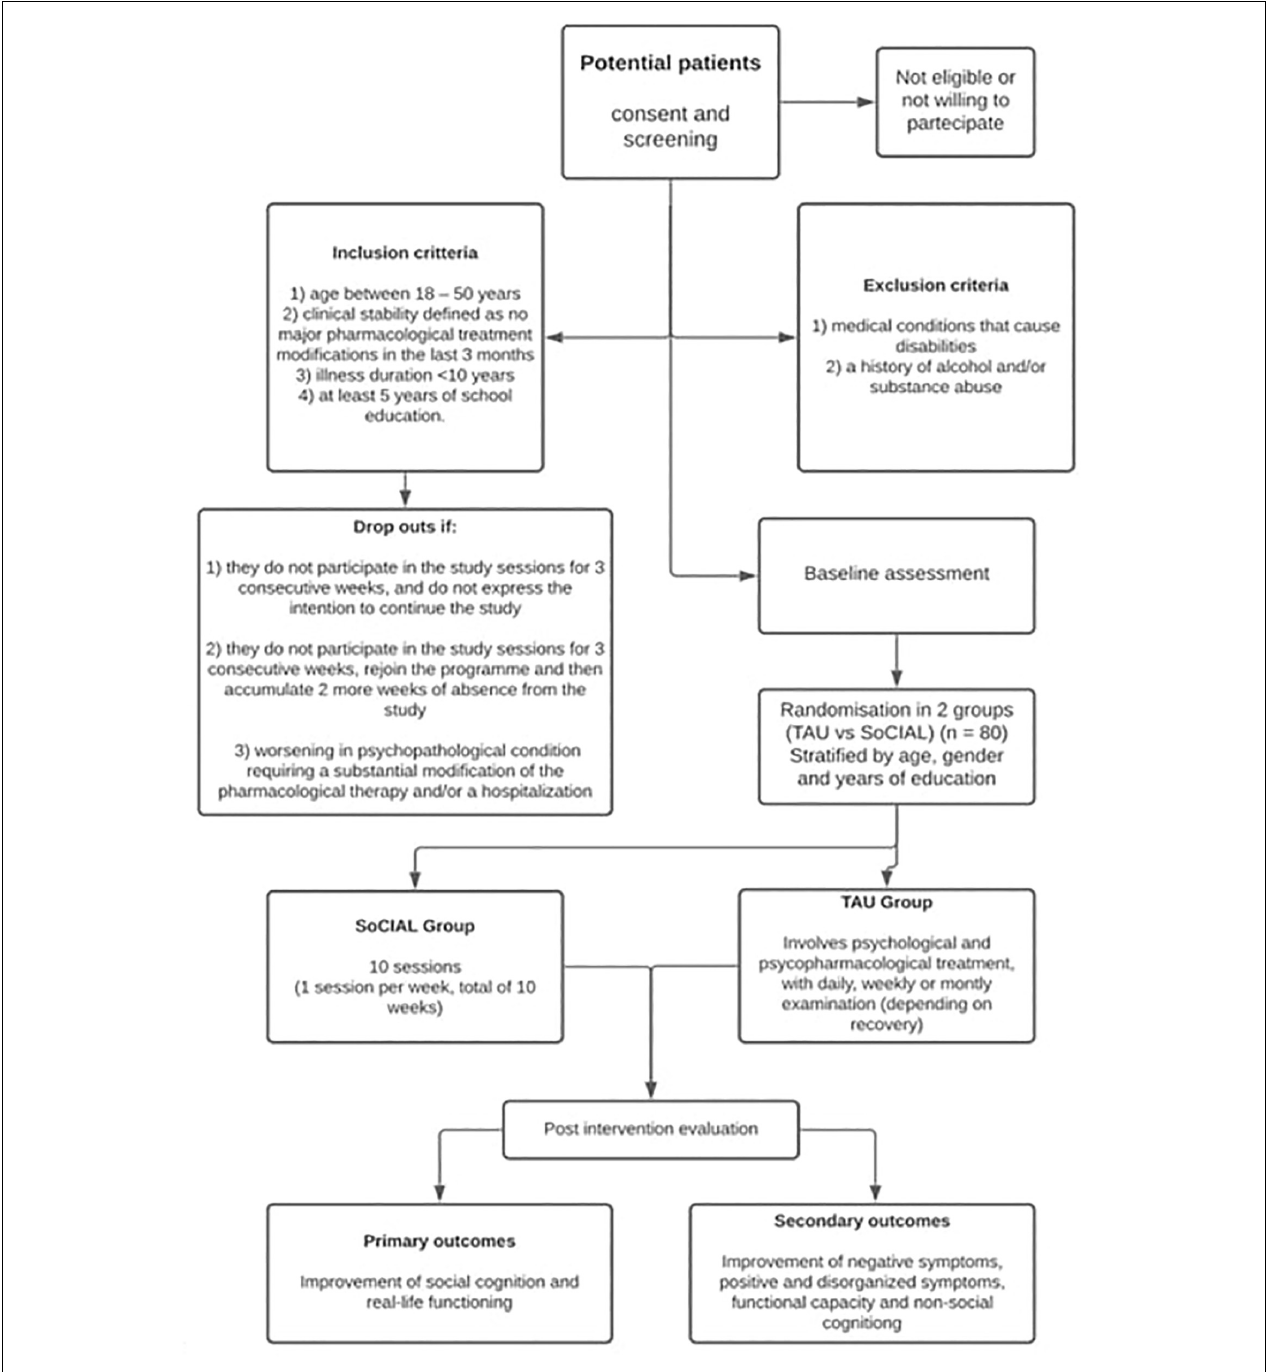
FIGURE 3 | Study flowchart: TAU: treatment as